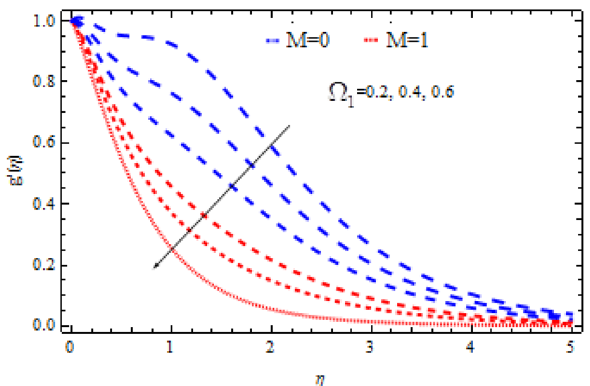
Figure 5. Consequence of (cid:31) 1 on g ′ .